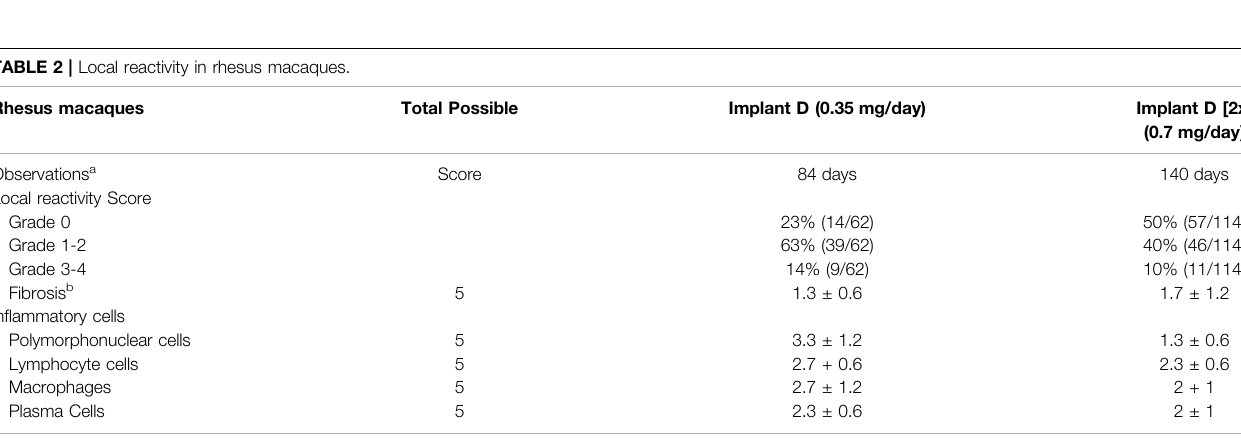
FIGURE 5 | Visual assessment of local skin reactions in the rhesus macaques using the Draize assessment.